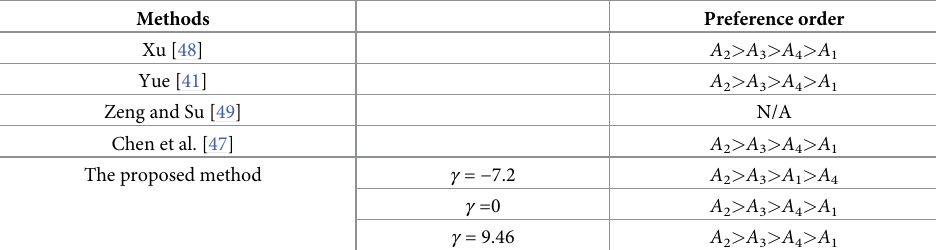
Table 7. A comparison of the orders of the alternatives of Example 1 for different